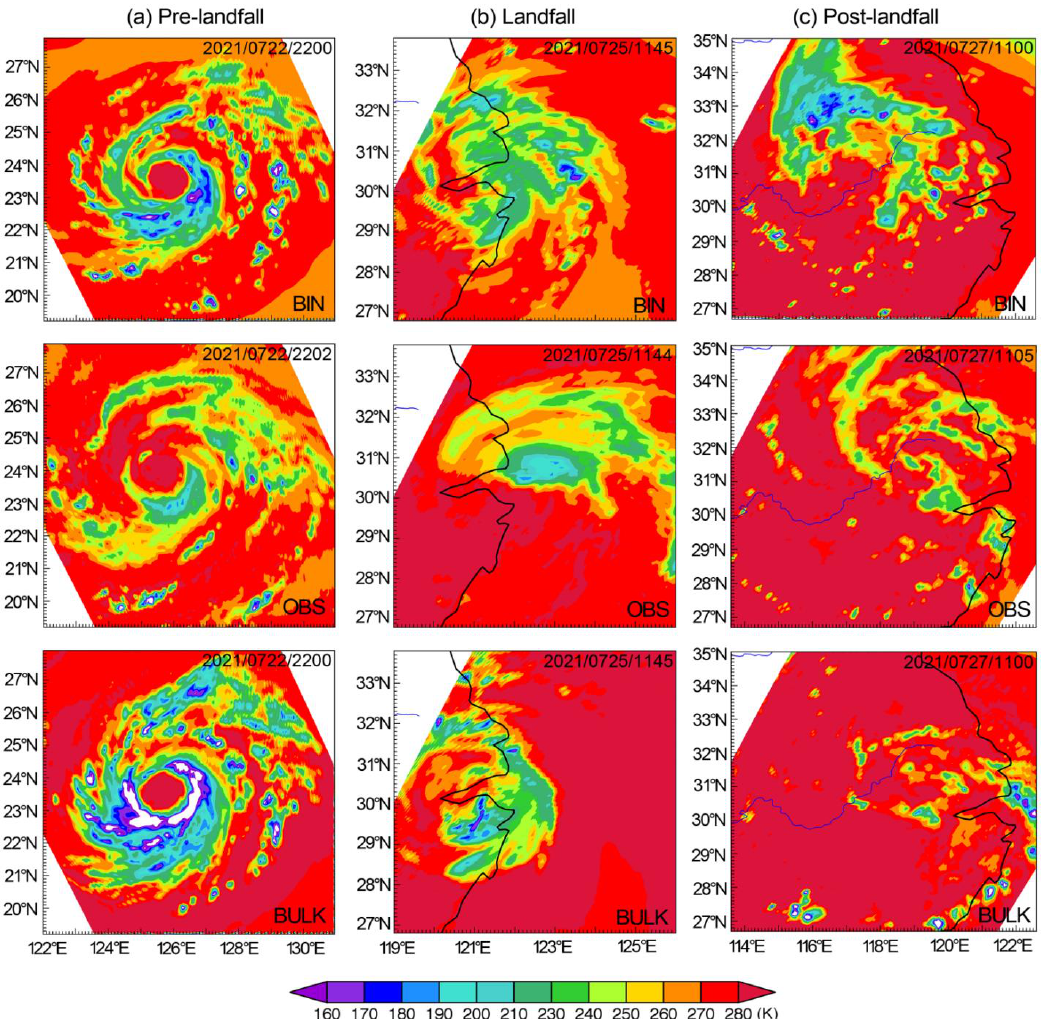
Figure 4. GMI satellite observation and WRF model simulation of brightness temperature (K) for Typhoon In-Fa (2021) during three different landfall periods. Typhoon In-Fa (2021) during three different landfall